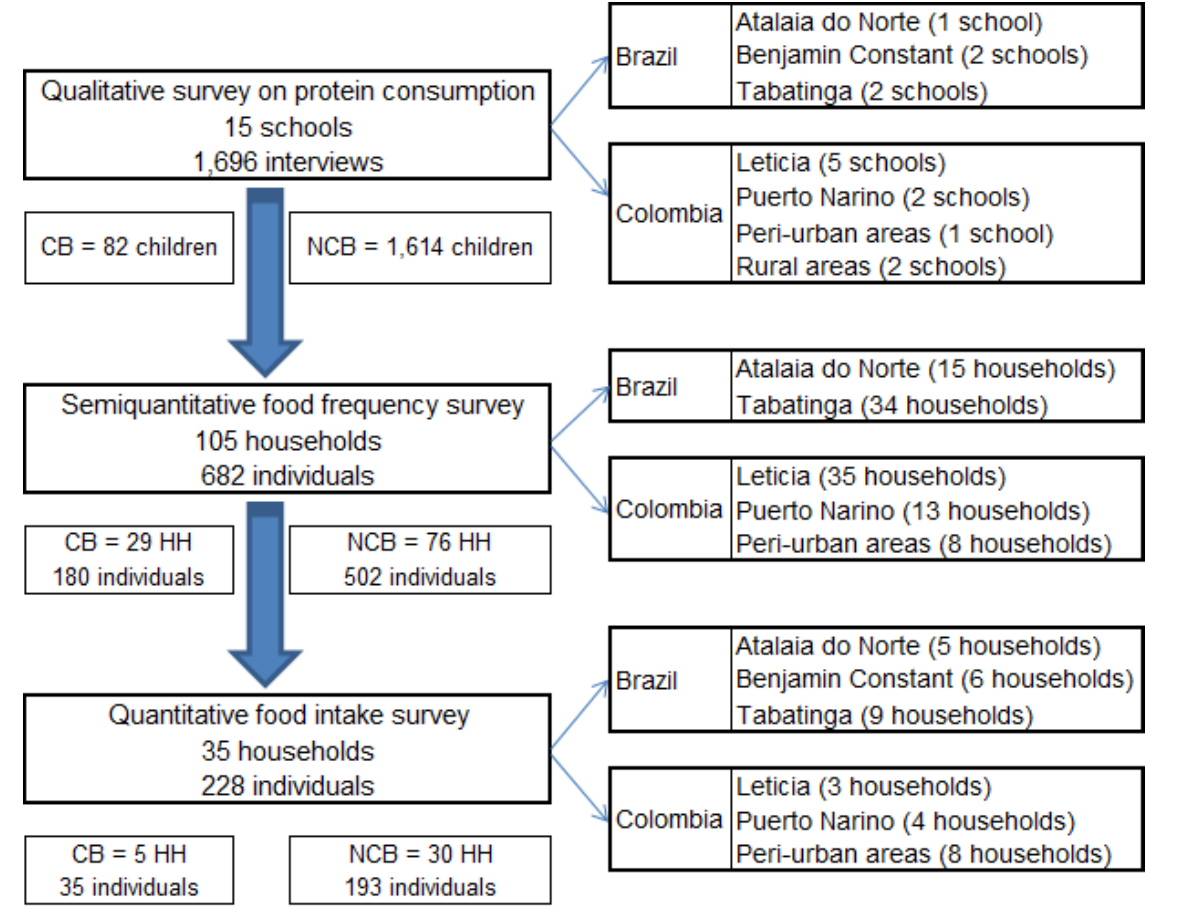
Fig. 2. Flow-chart illustrating the study design. CB = consuming bushmeat, NCB = not consuming bushmeat, HH =